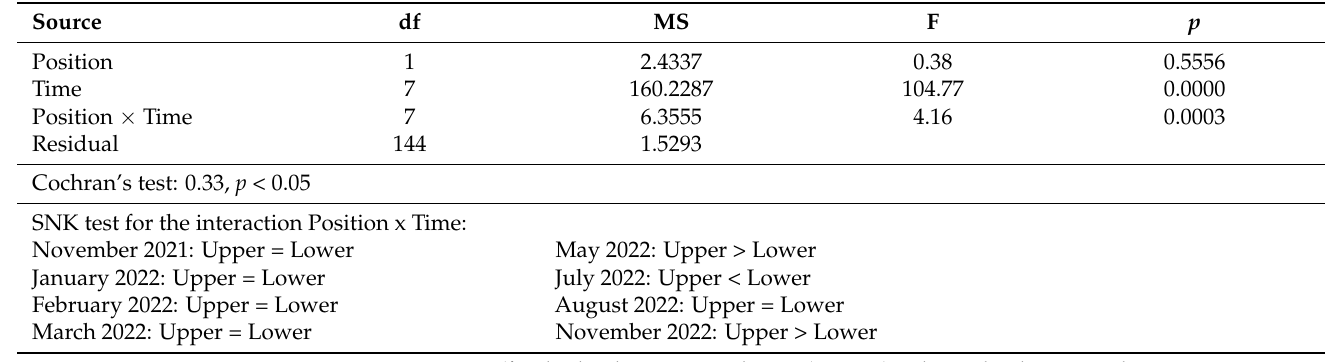
Table 1. Two-way ANOVA testing the effects of two positions of Fucus virsoides in the intertidal (upper and lower) on thallus growth.